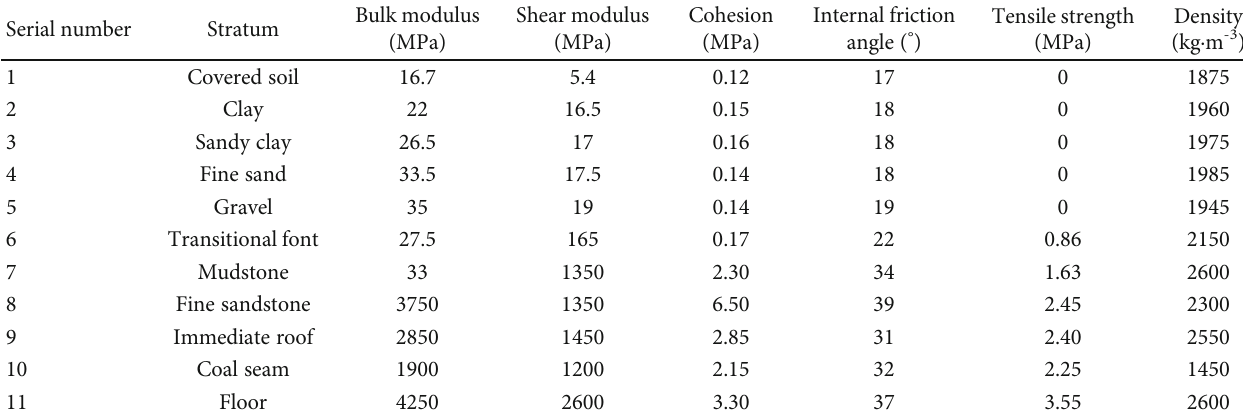
Figure 9: Schematic diagram of working face geological model. Table 1: Numerical simulation of material mechanics